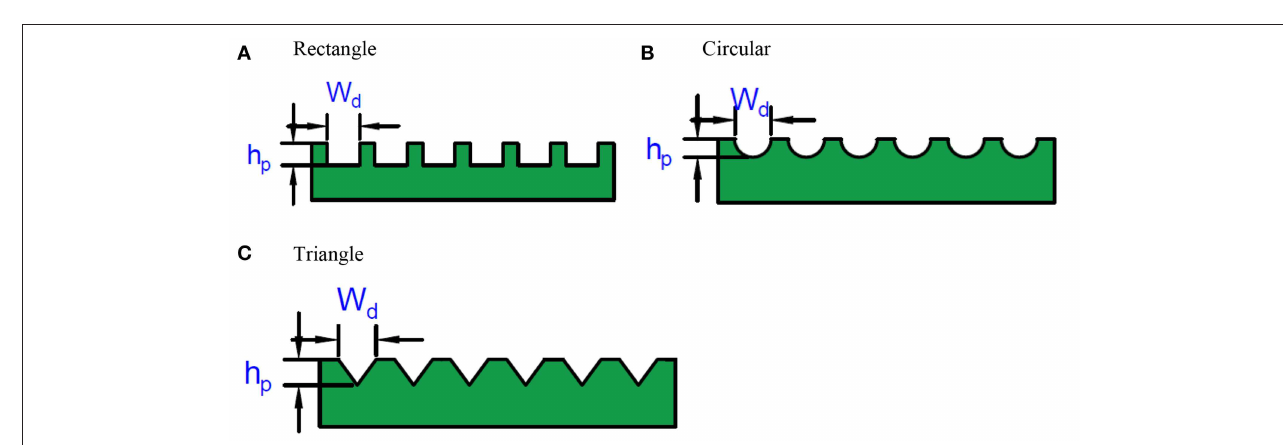
FIGURE 2 | Micro textures shapes (A) Rectangle; (B) Circular; (C)